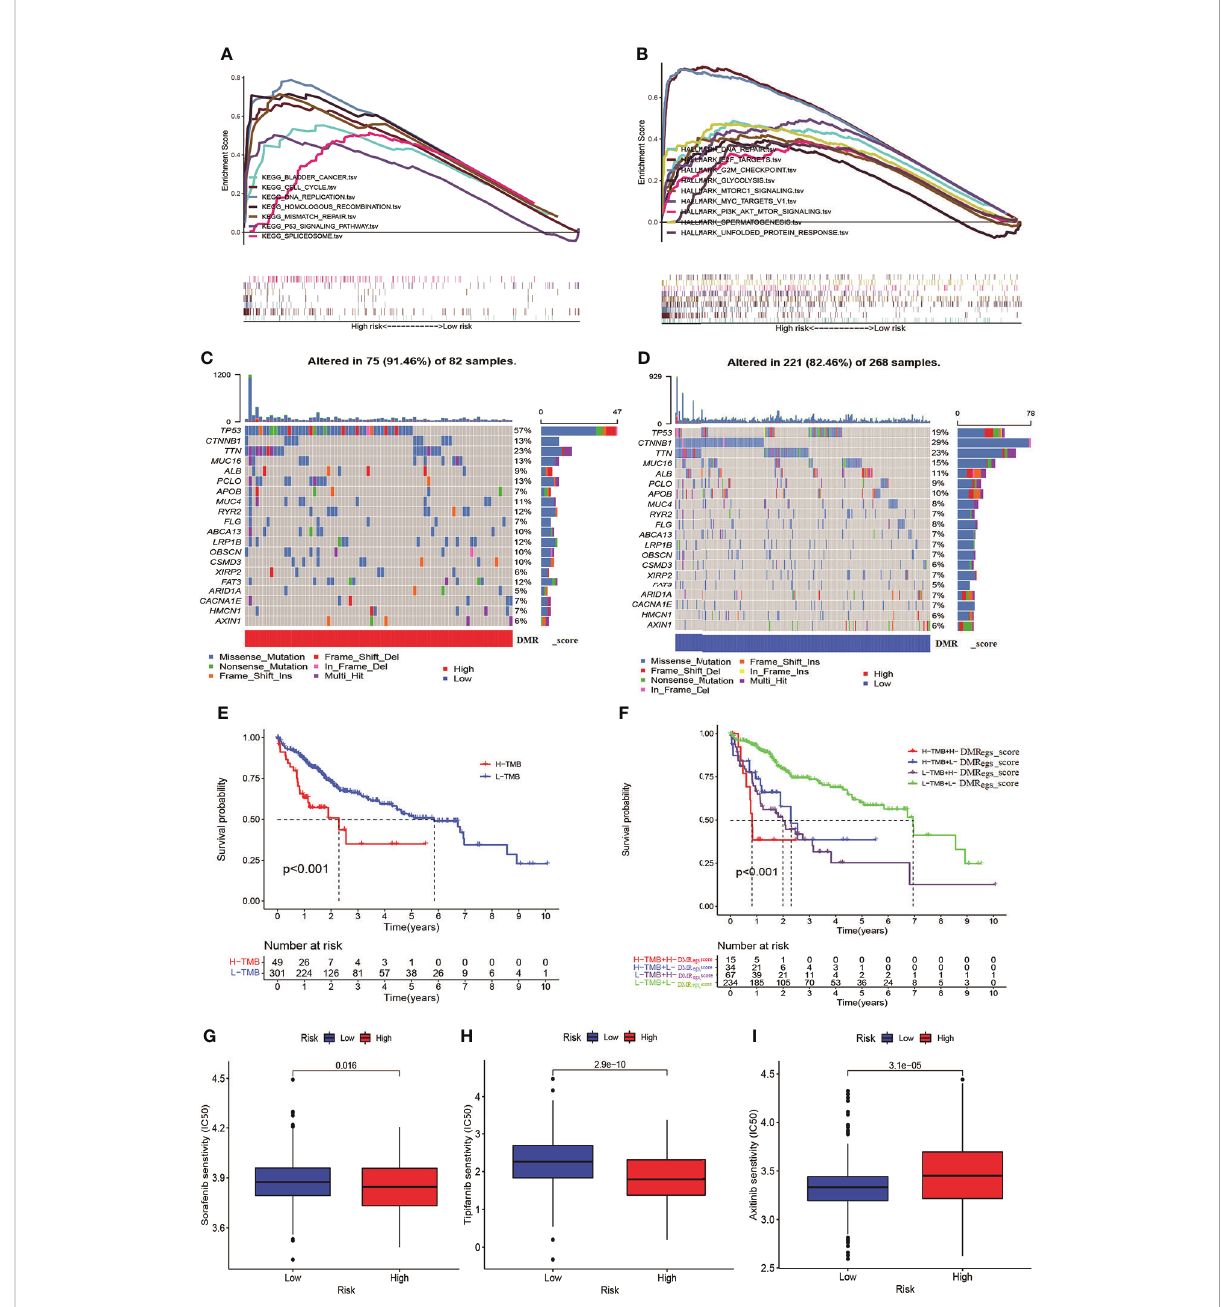
FIGURE 9 The TMB and drug sensitivity analysis for patients with different risk score. (A, B) The GSEA analysis in different risk groups. (C, D) The characteristics of tumor genetic alterations in two risk groups. (E) The survival analysis of patients with different TMB. (F) The survival analysis among four patient groups strati fi ed by both TMB and DMRegs_score. ( G – I ) The drug sensitivity analysis of patients with different risk score. TMB: tumor mutation